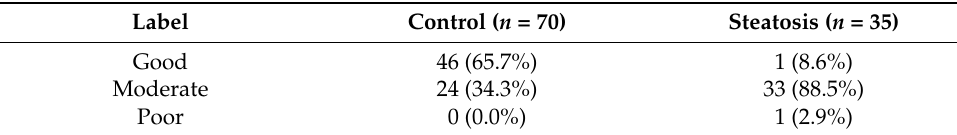
Table 4. Subjective adequacy analysis of